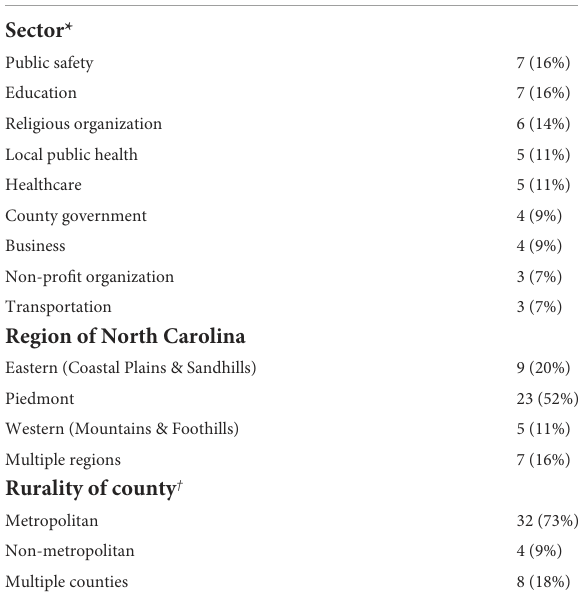
TABLE 1 Characteristics of organizations represented in interviews with local decision-makers ( N =